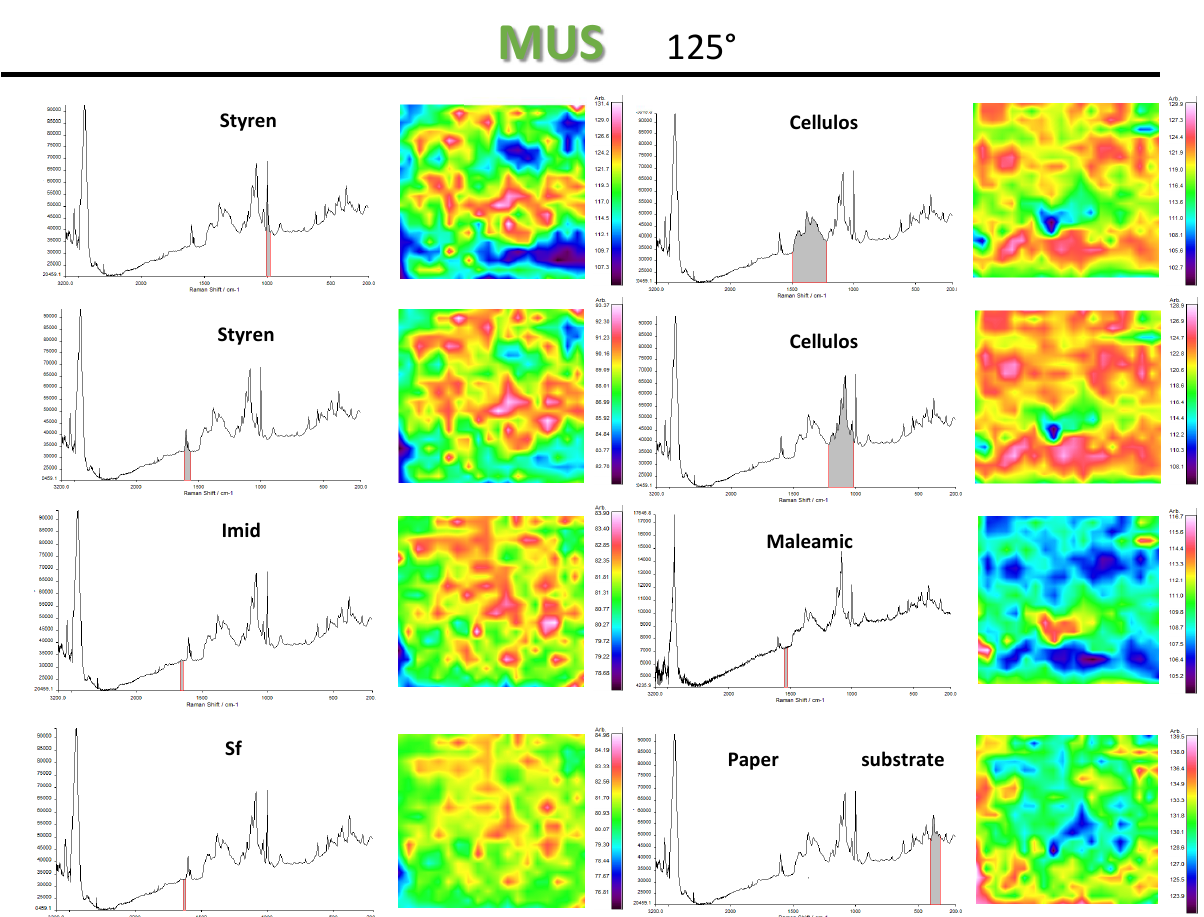
Figure 13. Raman spectroscopy surface maps of SMI/SfO-MUS coatings at 125 ◦ C (1 × 1 mm 2 ), representing chemimaps for different spectral